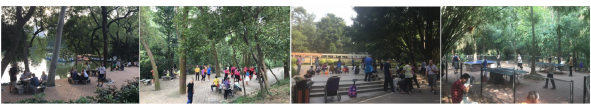
Figure A3. Recreation spaces in Tianhe Park.